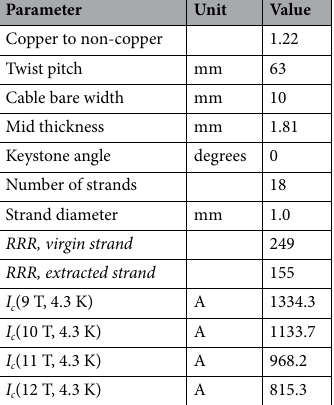
Table 1. Main parameters of the 1.8 m-long Rutherford cable and the Nb 3 Sn PIT wire. The critical current values refer to the measurements performed on the extracted strand (witness